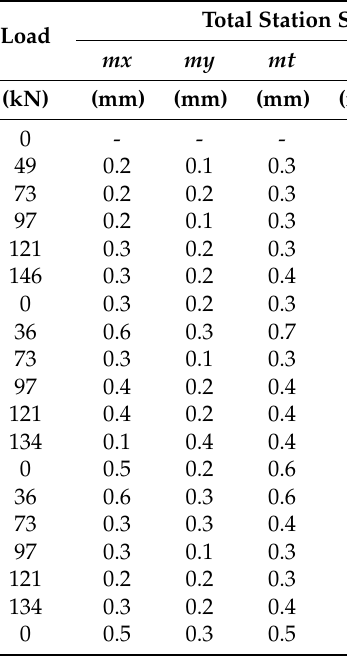
Table 2. The results of the stability control of the reference points (transformation errors for horizontal position mt and along both axes: mx , my , as well as the standard deviations sh of instrument height calculated for each step and differences of the instrument height dh between the initial and subsequent steps) calculated on the basis of measurements from MTS and